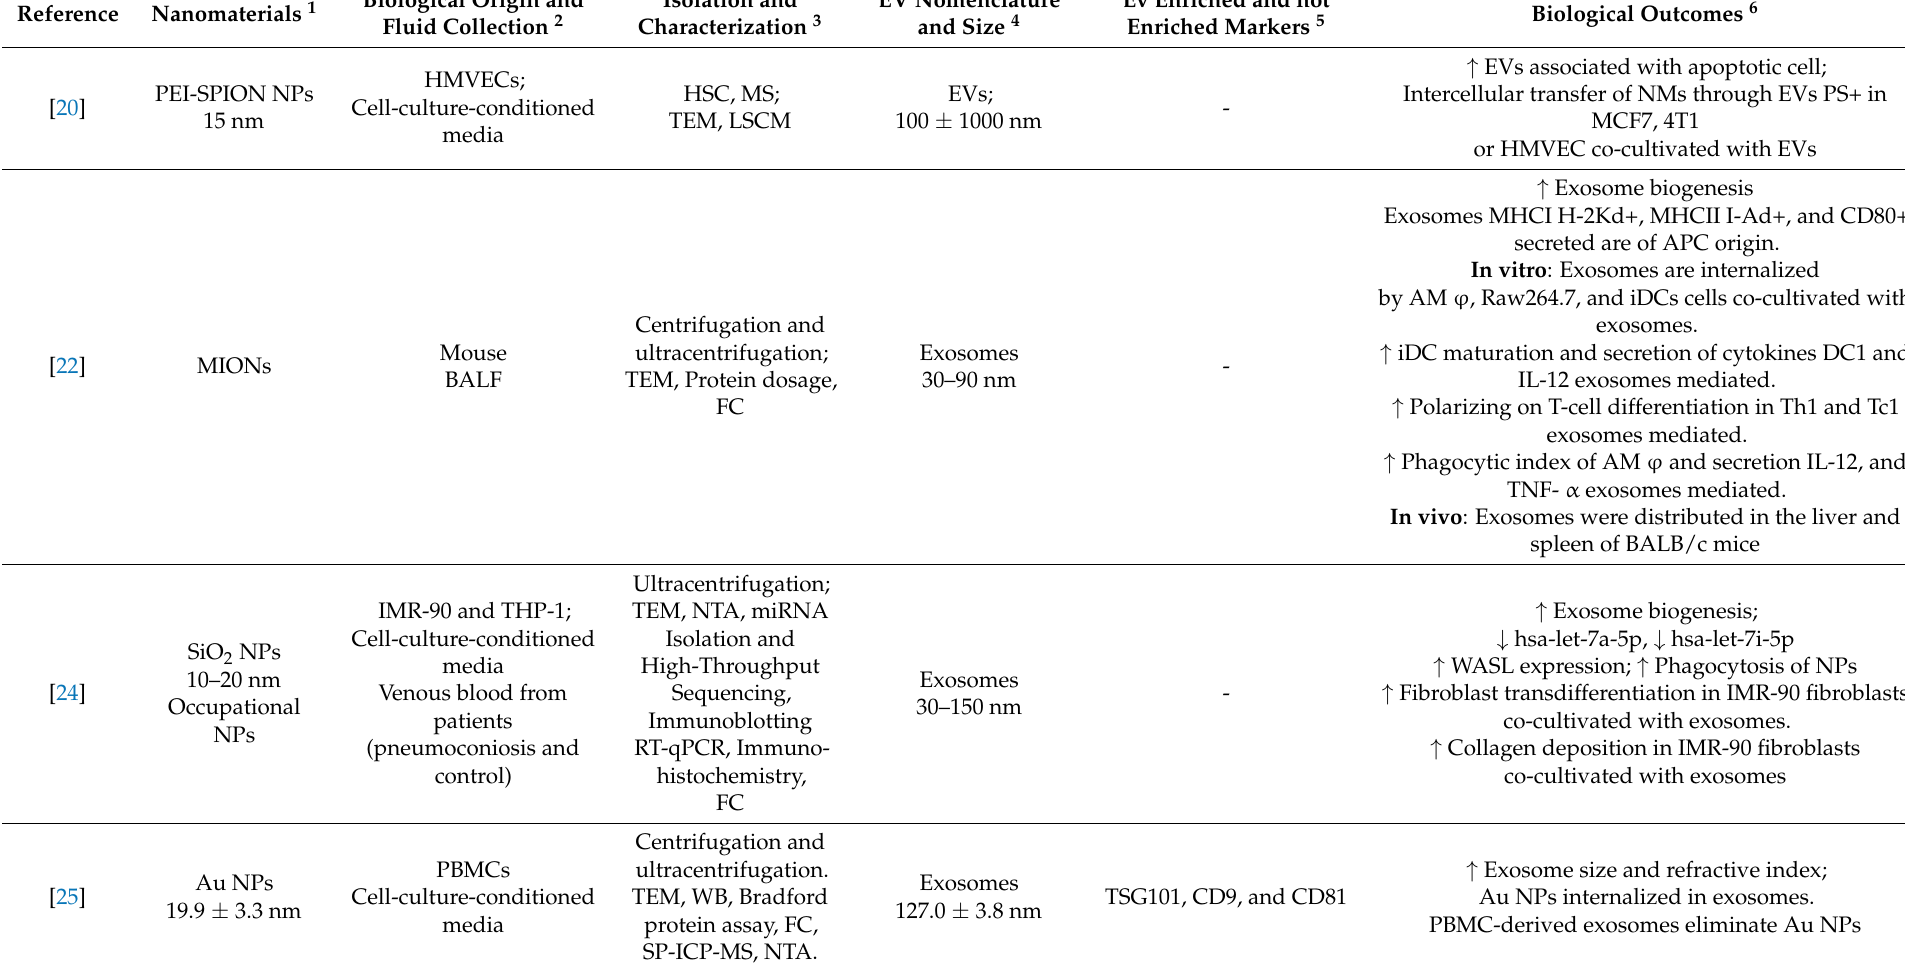
Table 3. Overview of the effects of NM exposure on EVs secretion and consequent biological